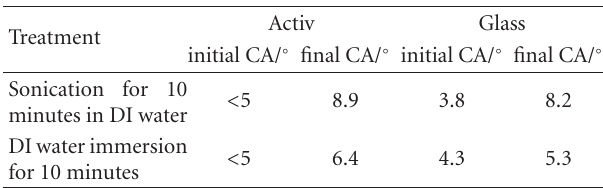
Table 2: Table of water contact angle for Activ and glass samples before and after either sonication or immersion for 10 minutes in deionised (DI)